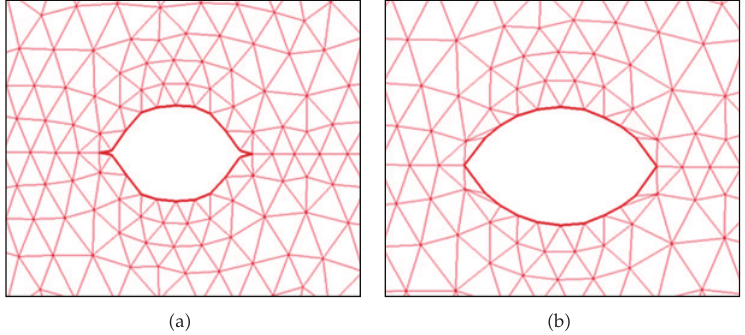
Figure 3: Deformed shape of MT specimen under uniform surface load with two di ff erent nodes searching algorithms (cid:2) a (cid:3) surrounding triangles (cid:2) b (cid:3) proposed